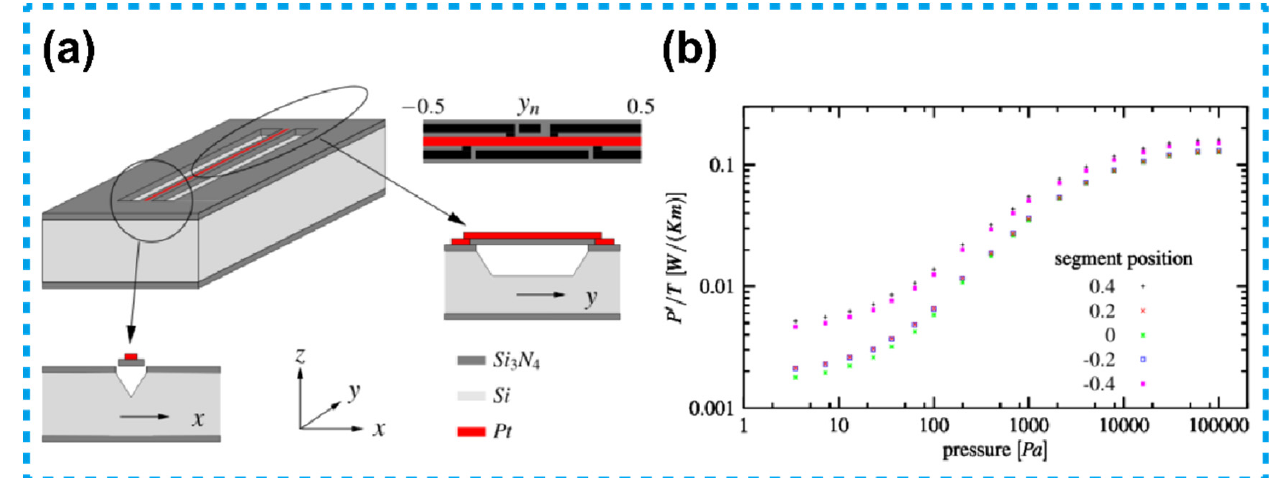
Figure 3. A vertical heat transfer configuration thermistor-based Pirani sensor with a V-shaped groove. ( a ) Schematic diagram of the sensor. ( b ) The power per unit temperature versus pressure, the sensitive range of the device was 3 to 10 5 Pa [75].